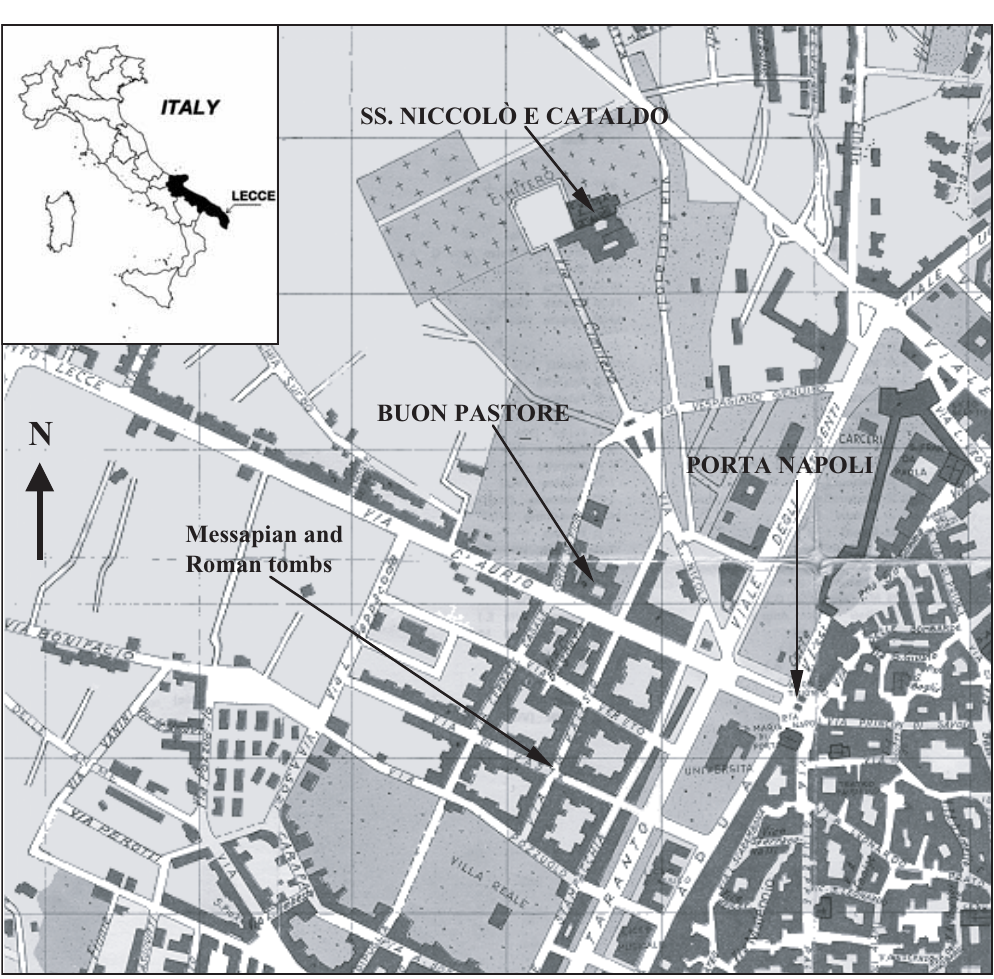
Fig. 1. Location map of the «Buon Pastore» study site in Lecce, Italy.